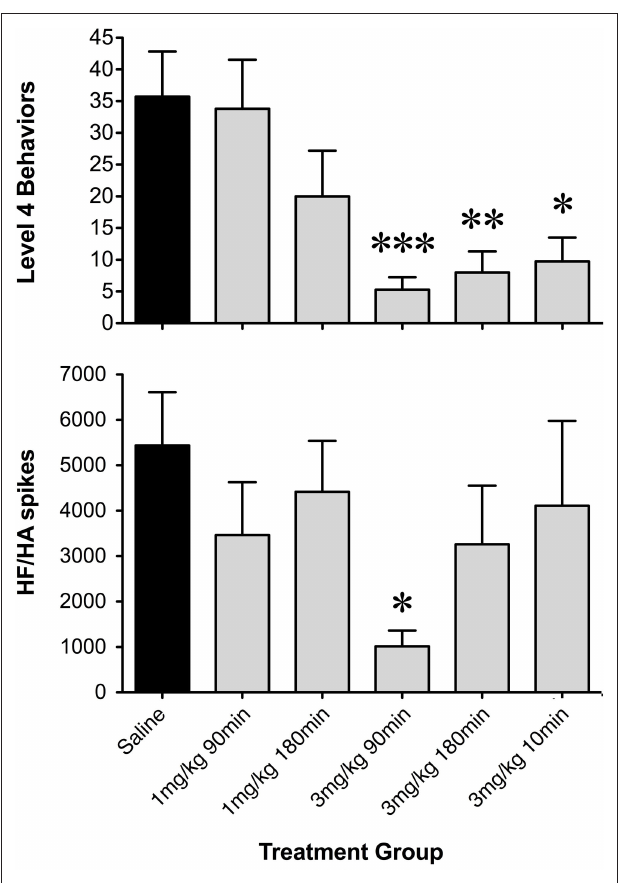
FIGurE 5 | Histograms of net occurrence of level 4 seizure behaviors and high frequency/high amplitude (HF/HA) electrographic spikes during the 2-h seizure induction period following saline or GYKI 52466 preconditioning. Totals were averaged within treatment groups (mean ± SEM; * p < 0.05, ** p < 0.01, *** p = 0.001).